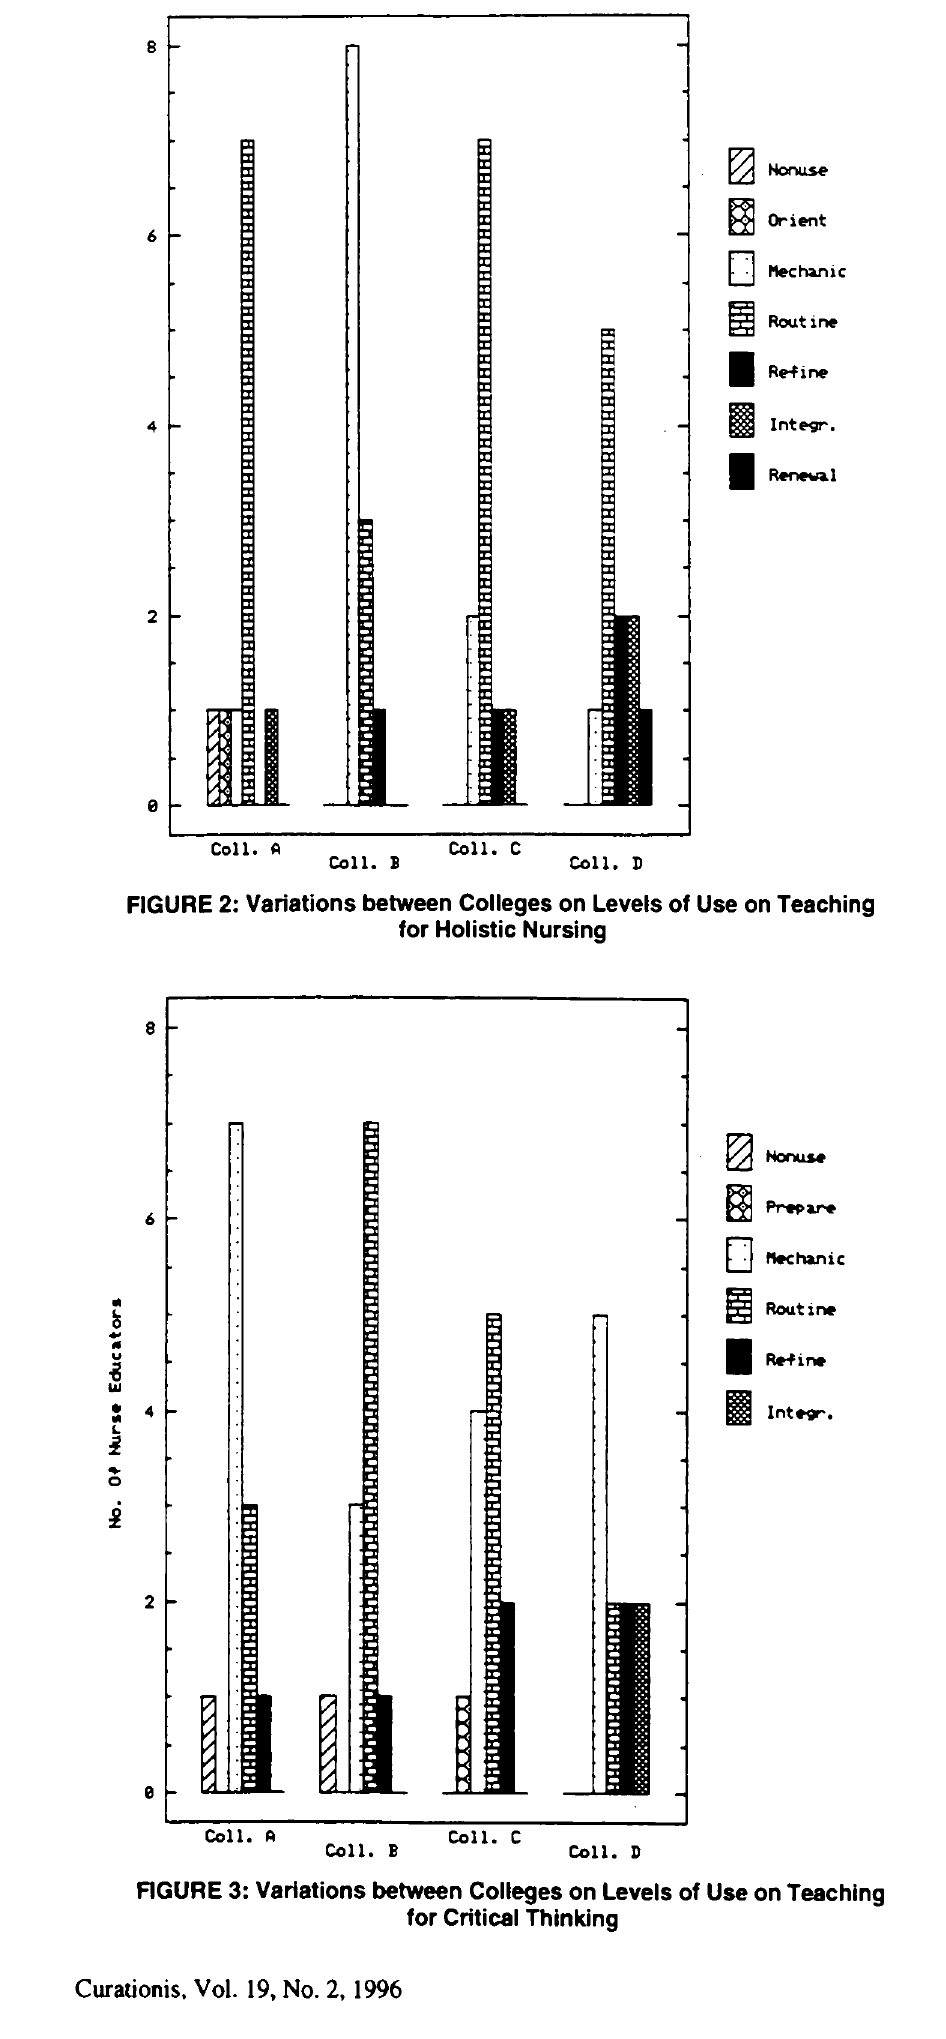
FIGURE 2: Variations between Colleges on Levels of Use on